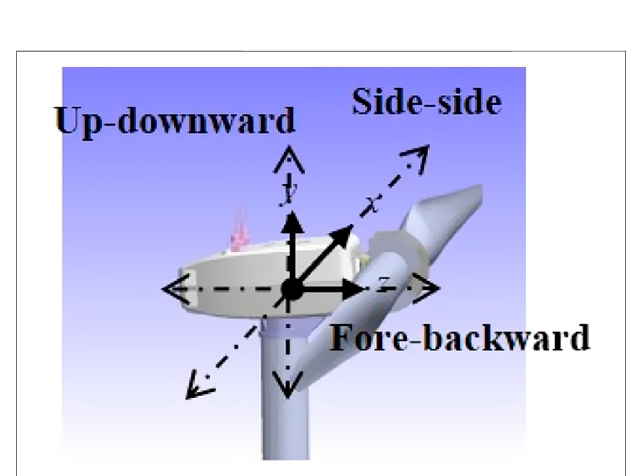
FIGURE 5 | Illustration of nacelle